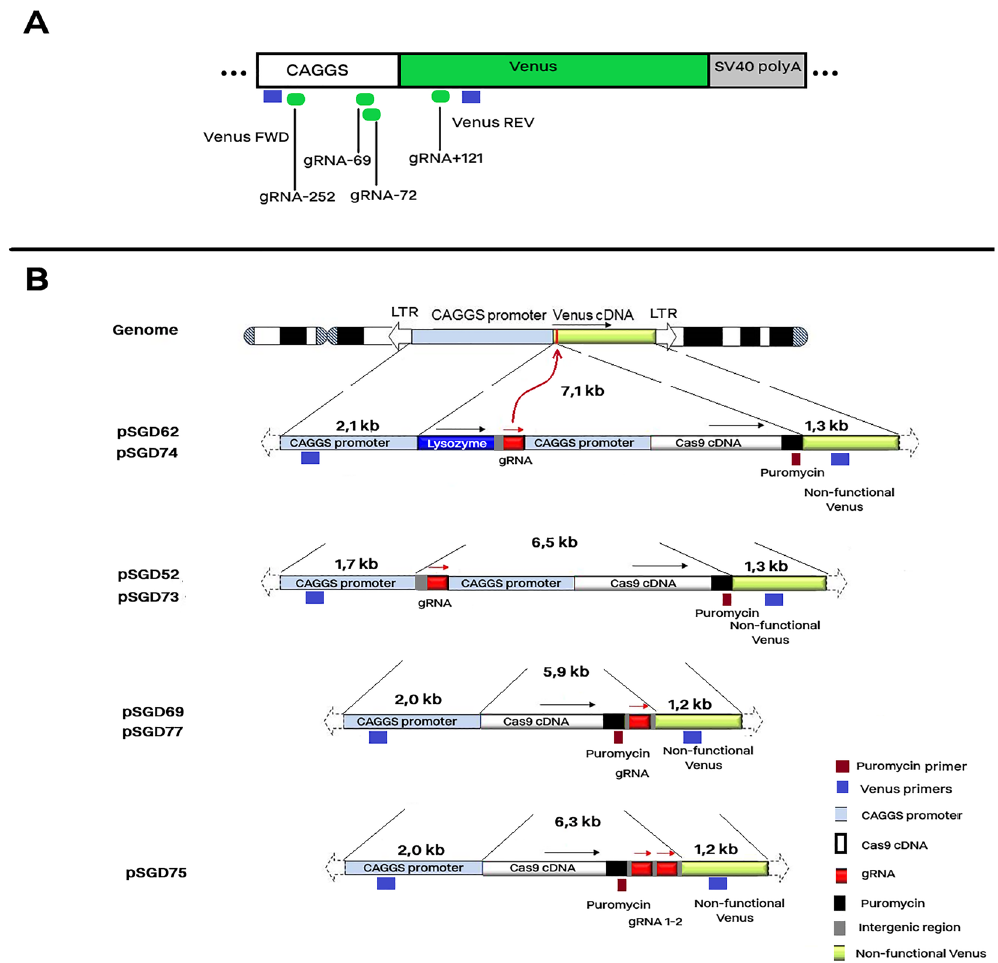
Figure 1. Schematic presentation of the gRNAs and large plasmids. ( A ) The location of three gRNAs on the CAGGS promoter and one gRNA on the 5´coding part of the Venus transgene. Forward and reverse primers for amplification of Venus are depicted in blue colour. ( B ) The genomic location of Venus transgene and its homology arms with SGD constructs as well as the insertion cassettes. Compared to the pSGD52, pSGD73 and pSGD74 constructs, the gRNA was translocated after the Cas9 and puromycin genes in pSGD69, pSGD75, and pSGD77. The location of a primer complementary to the puromycin sequence is depicted with a red box. This primer was used combined with the Venus Rev primer for detection of the HDR-mediated SGD insertion into the Venus transgene. pSGD 52 and 62 contained gRNA-252, pSGD73, 74, and 77 contained gRNA-72, pSGD 69 contained gRNA-69, and pSGD75 contained both gRNA-72 and + 121. The figure was created in Microsoft PowerPoint